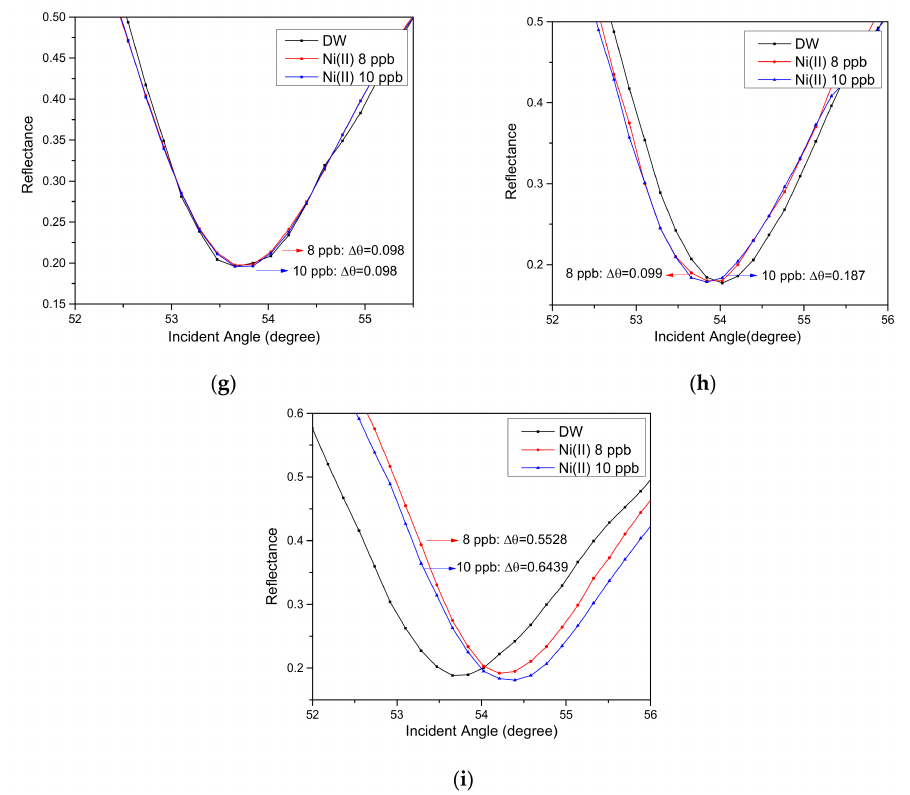
Figure 2. The surface plasmon resonance (SPR) reflectance curve for ( a ) Au; ( b ) Au/3-mercap- topropionic acid (MPA); ( c ) Au/V; ( d ) Au/cellulose nanocrystals (CNCs); ( e ) Au/CNCs– hexade- cyltrimethylammonium bromide (CTA); ( f ) Au/V–CNCs; ( g ) Au/V–CNCs–CTA; ( h ) Au/MPA/V– CNCs; ( i ) Au/MPA/V–CNCs–CTA thin film when detecting 8 ppb and 10 ppb of Ni(II) ion